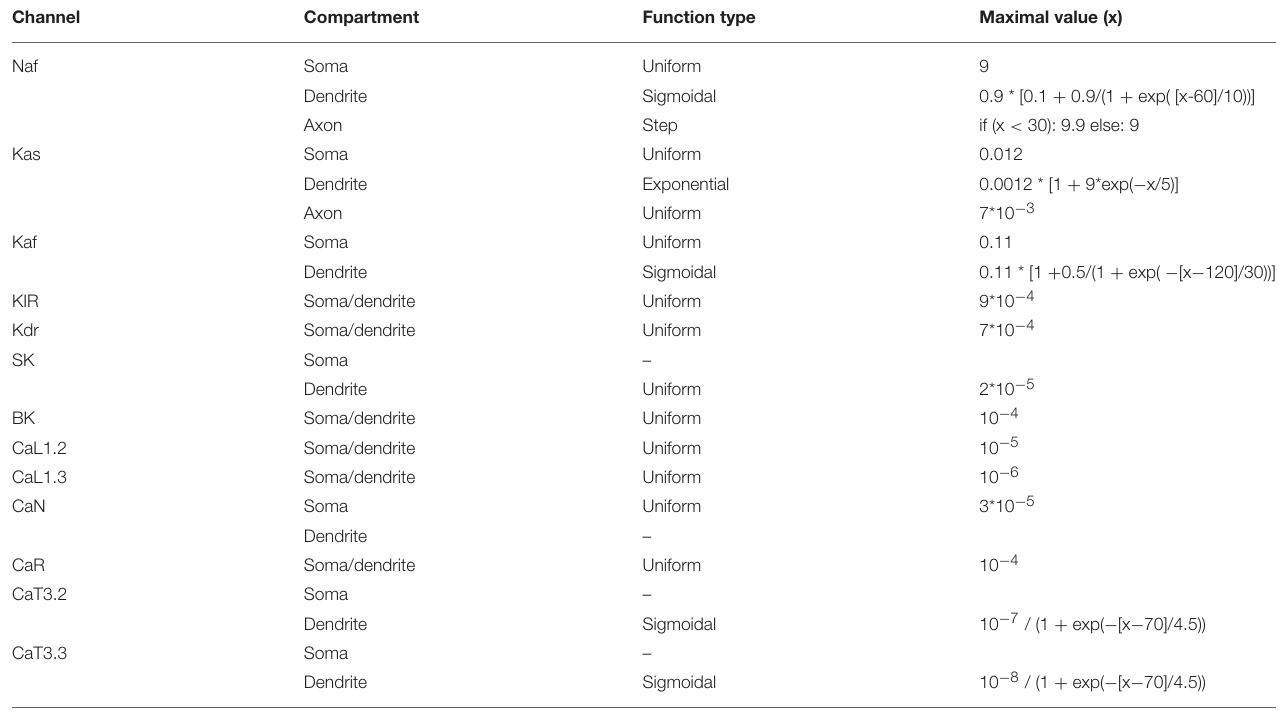
TABLE 2 | Channel distribution over cell compartment as a function of somatic distance